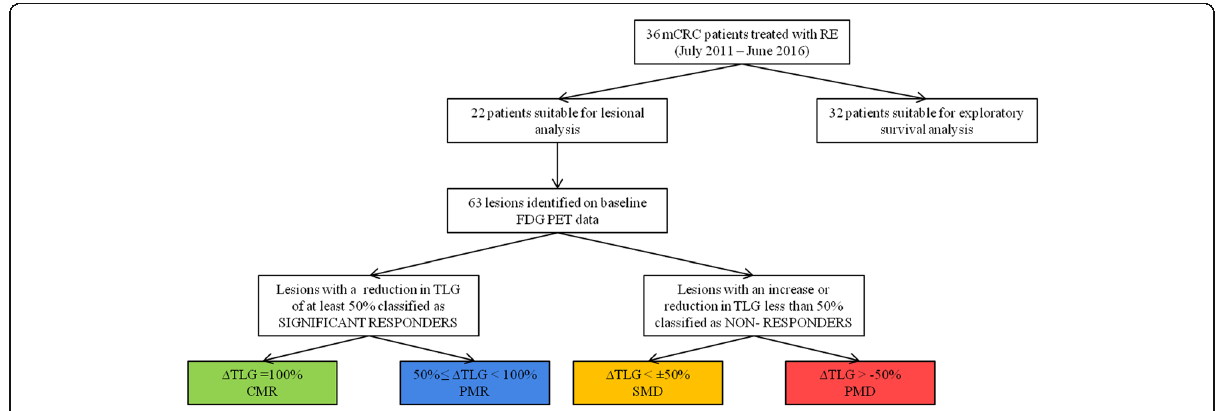
Fig. 1 Flowchart representing the patient cohort for analysis and categorisation